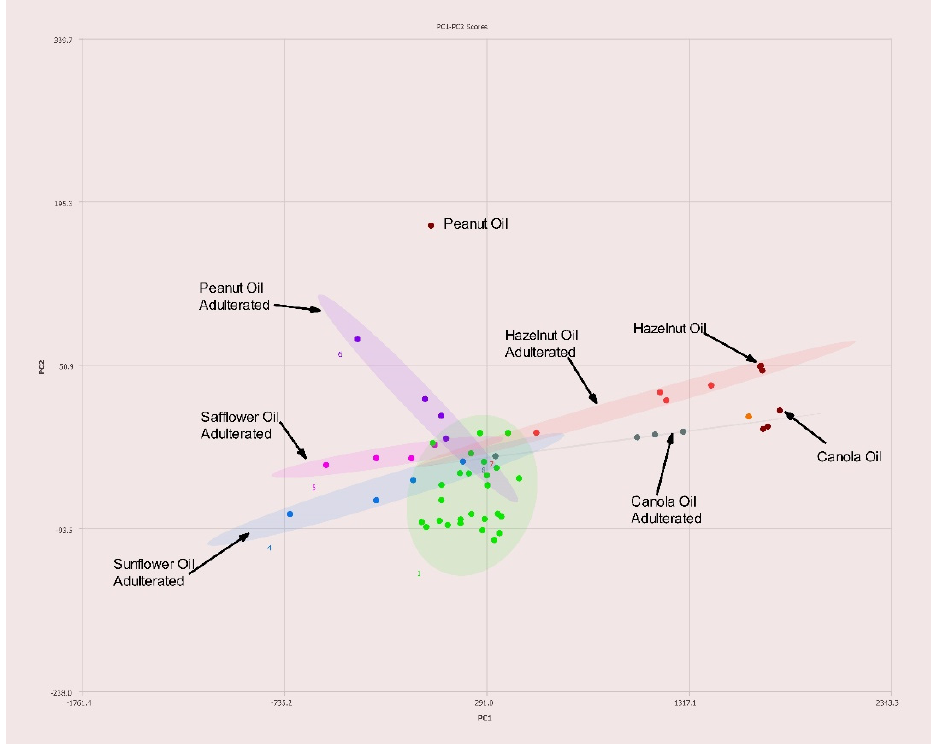
Figure 5. PC1–PC2 plot of 400 MHz 1 H NMR spectra of seed oils (labeled) versus olive oils (green). Ellipses represent the 95% confidence interval.